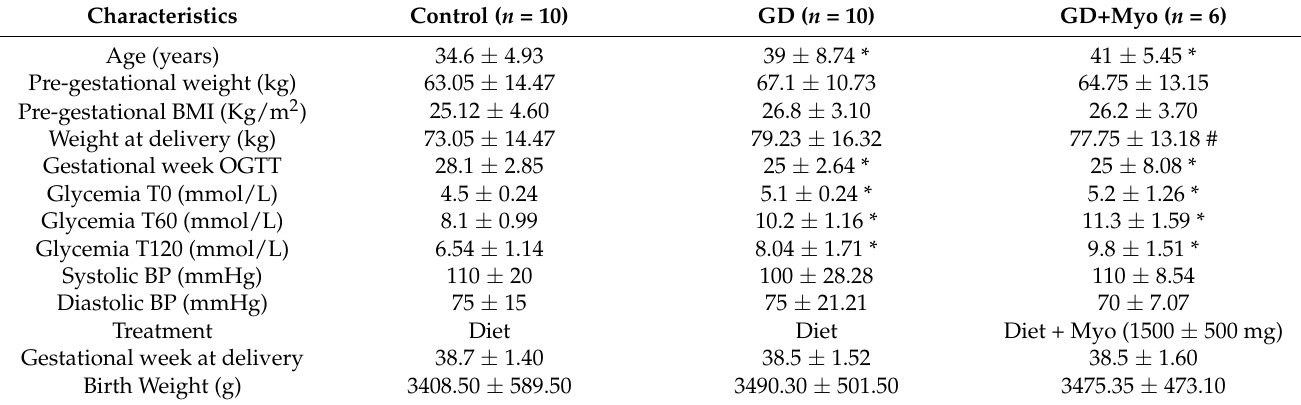
Table 1. Characteristics of women from whom umbilical cords were obtained and birth weight of newborns at delivery.